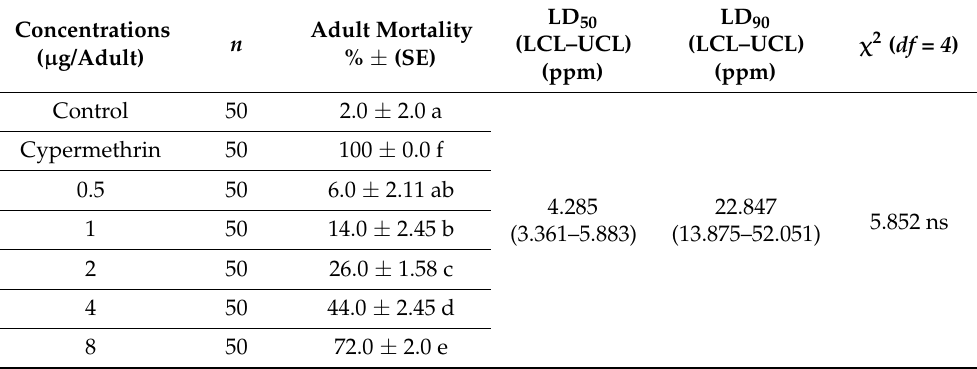
Table 4. Adulticidal activity of Hi -ZnO-NPs against the housefly, Musca domestica adults.